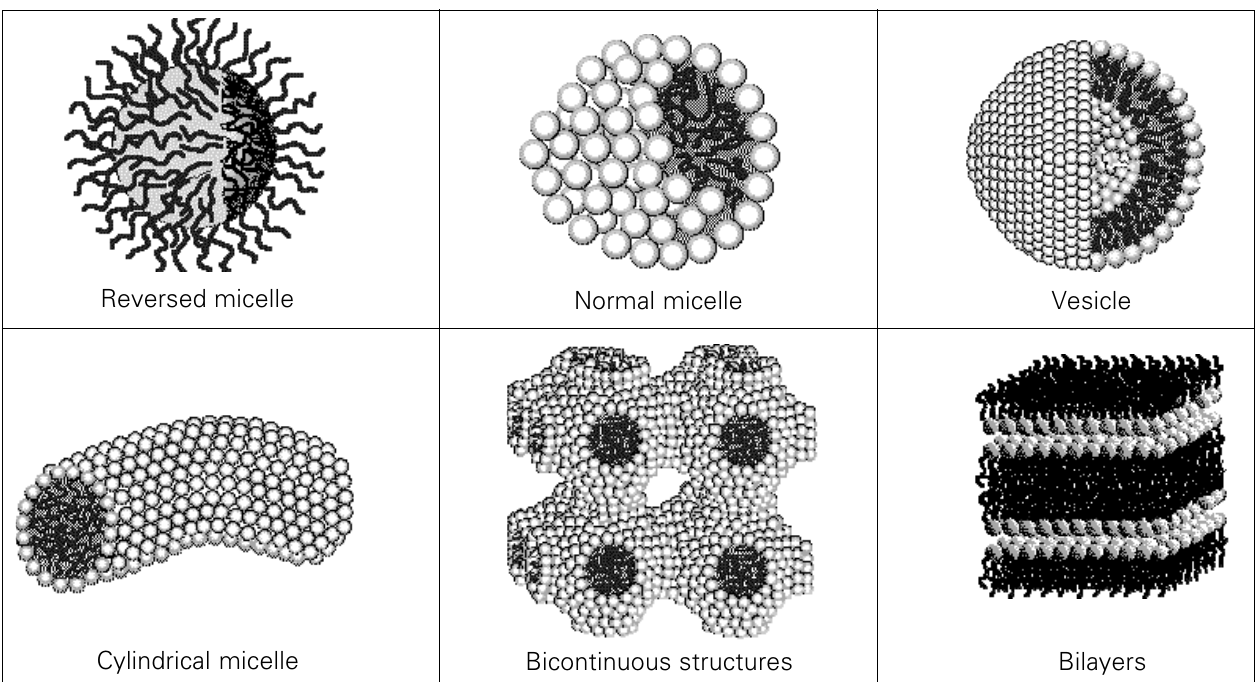
Figure 1 - Typical biomimetic